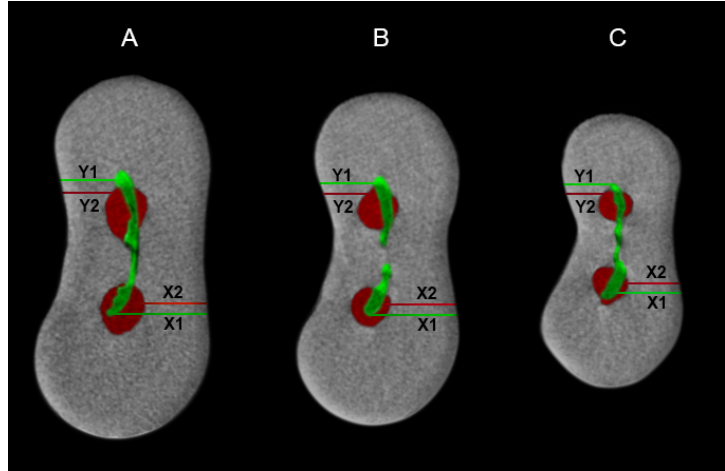
Figure 1. Cross-sectional images representing reference points of measurements before (green) and after (red) root canal preparation at 9 ( A ), 6 ( B ) and 3 mm ( C ) from the apex.